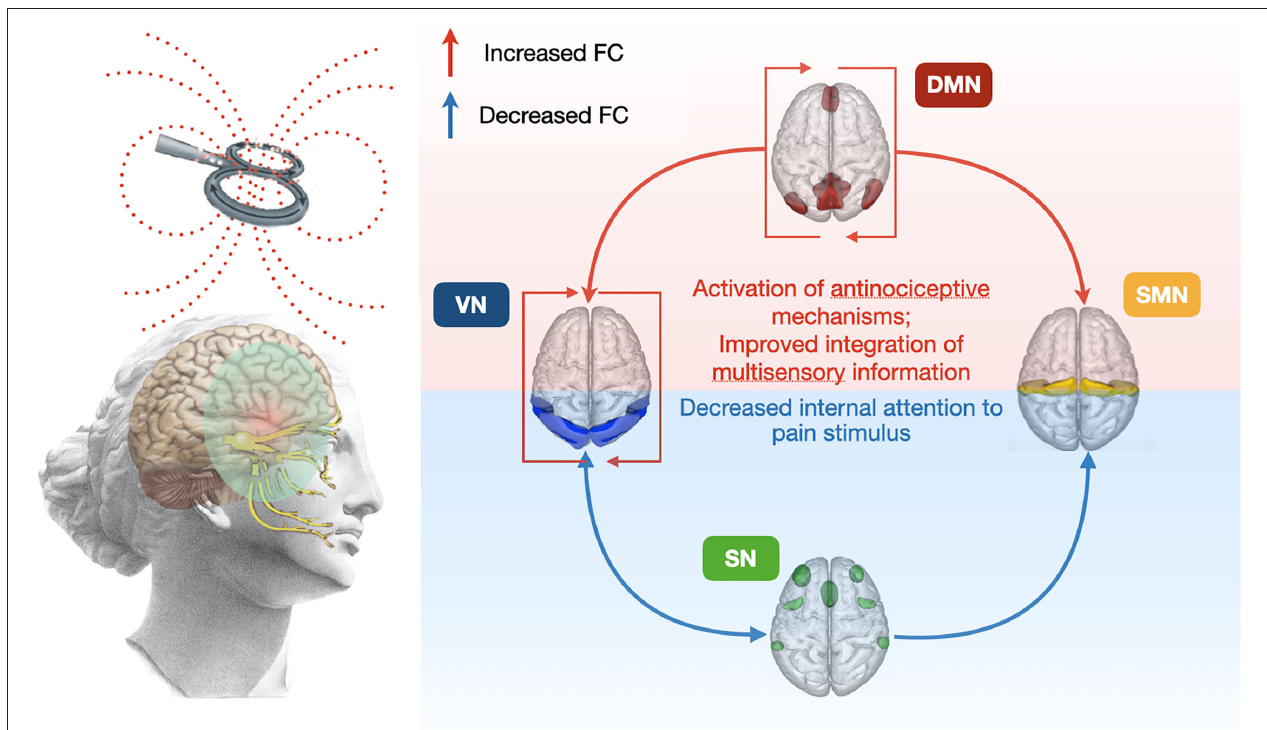
FIGURE 3 | The overall scheme of 5-day rTMS course affects changes in FC between main resting-state neural networks. FC, functional connectivity; VN, visual network; DMN, default mode network; SN, salience network; SMN, sensorimotor